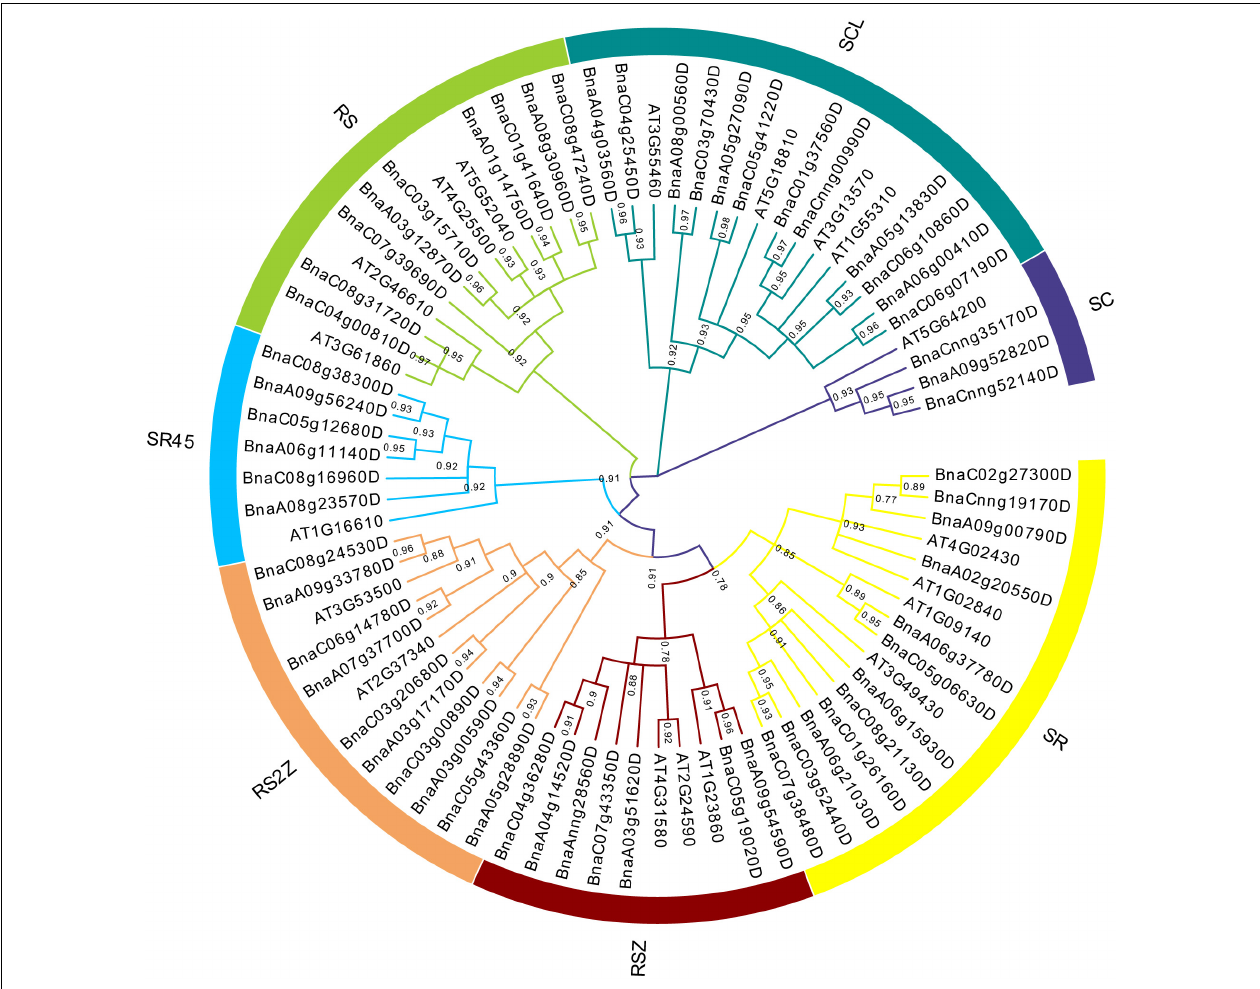
FIGURE 1 | Phylogenetic analysis of SR proteins in B. napus and A. thaliana . All SR proteins were clustered into seven subfamilies, and each subfamily was represented by a different